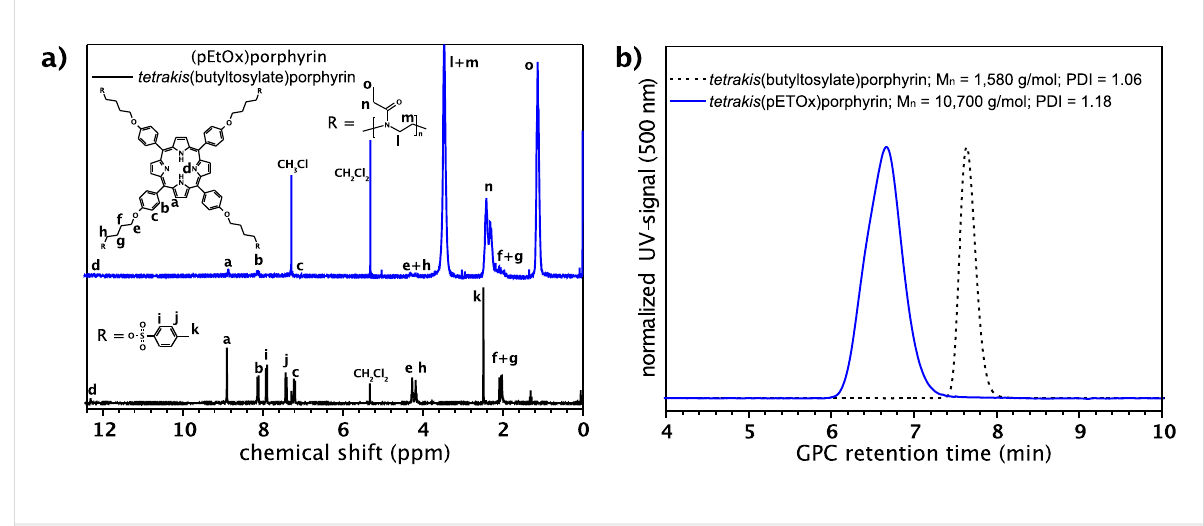
Figure 9: a) 1 H NMR spectra (in CDCl 3 ) of the porphyrin initiator TetraTos-B (bottom) and star-pEtOx (top). b) SEC traces of TetraTos-B and star- PEtOx (in CHCl 3 :NEt 3 :2-PrOH; UV-detector at 500